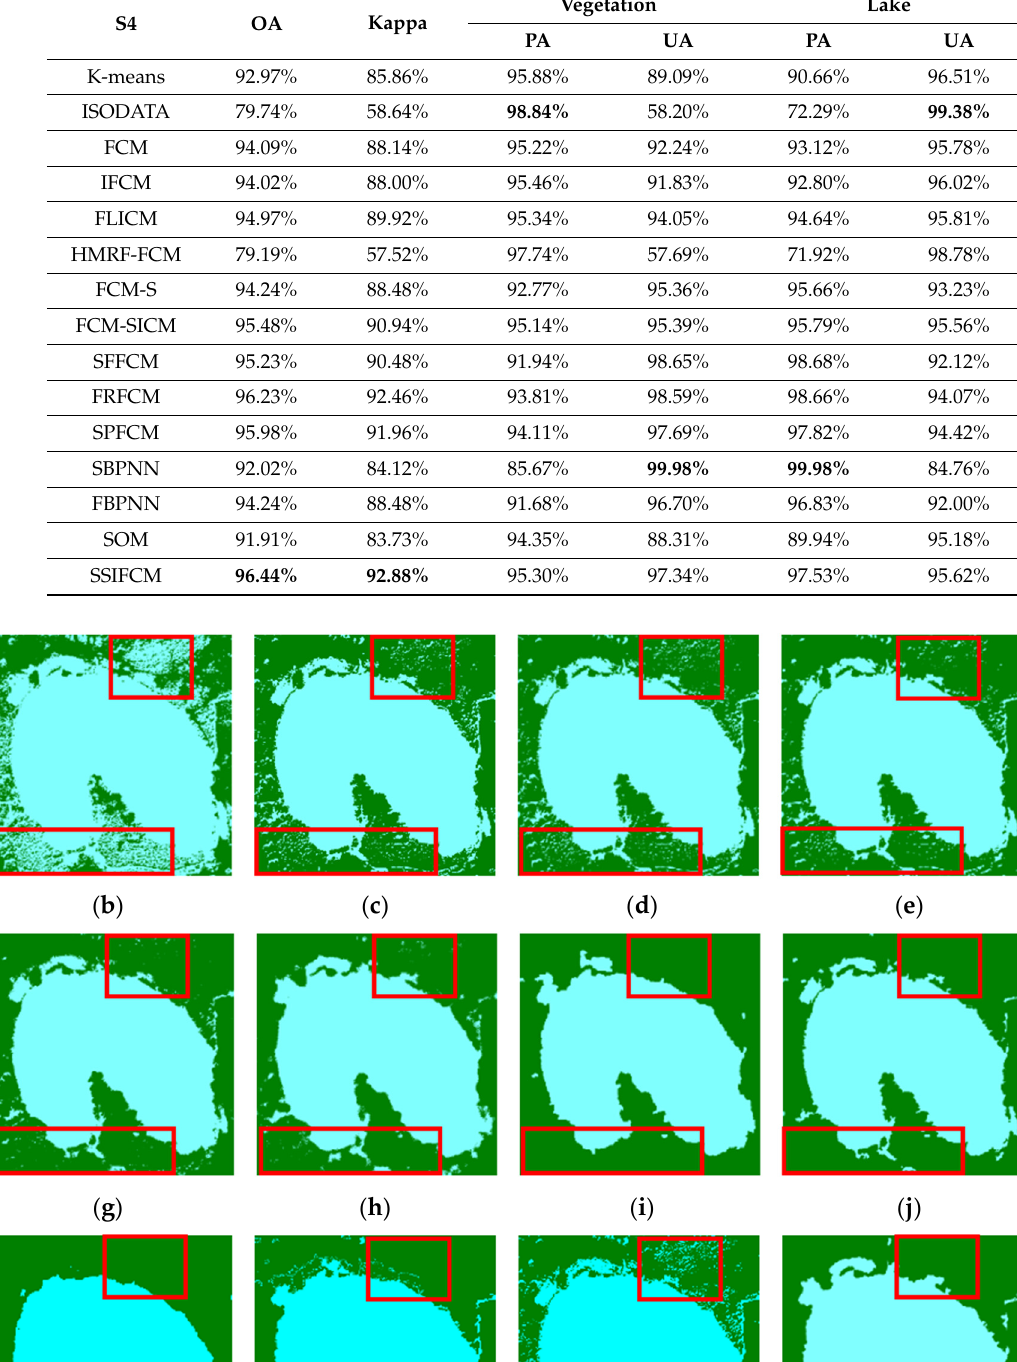
Table 8. Evaluation of S4 image classification results.